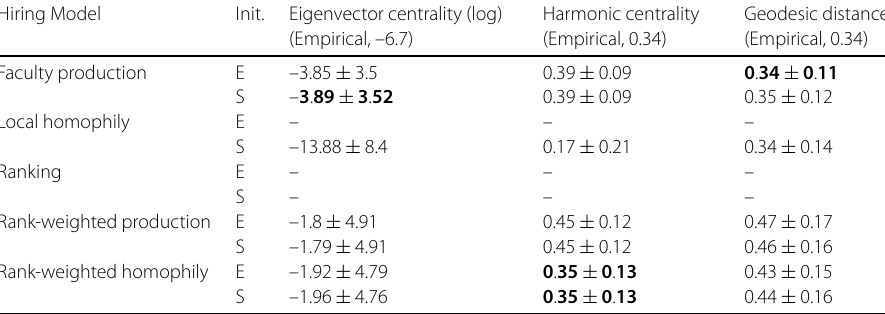
Table S5 Mean value of network summary statistics for five hiring models vs. the empirical values for Computer Science. Mean values of the three network summary statistics—eigenvector centrality, harmonic centrality, and normalized mean geodesic distance—for networks produced by each of the five hiring models vs. the corresponding values of the empirical Computer Science network. Boldface values are close to the empirical value. Uncertainty indicates the average absolute distance between predicted and empirical value. For this comparison, parameter combinations achieving the closest structural inequality are applied when β = 1.0 (Table S3). Two initializations (Init.) of Egalitarian (E) and Skewed (S) are used. Dashed line represents the Ranking and Local homophily model are unable to reproduce realistic structural inequalities. All values are rounded to the second digit Hiring Model Init. Eigenvector centrality (log) (Empirical,